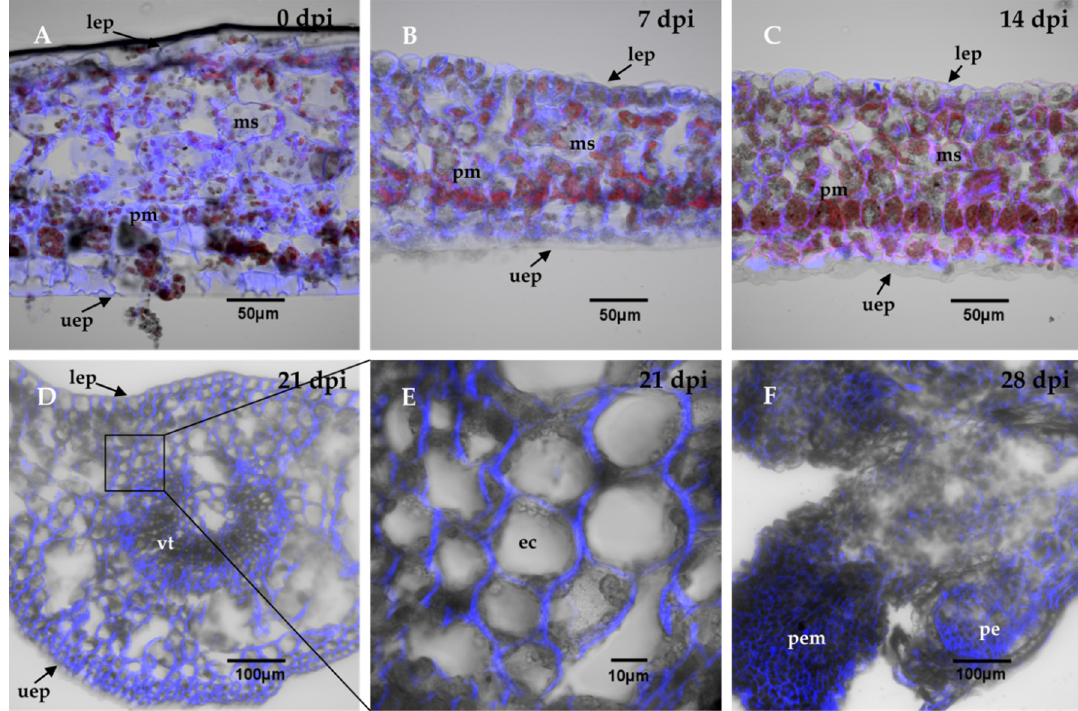
Figure 2. Histological analysis during the SE induction process in C. canephora . The leaf explants were composed of parenchymal cells of the spongy mesophyll, sm, and palisade mesophyll, pm. There were no changes in the explant cell structure, as shown in panel ( A ), which corresponds to the induction day (0 day); ( B ), 7 dai, and ( C ), 14 dai. ( D ), From 21 dai, the appearance of embryogenic cells, ec, was observed near the vascular tissue, vt. ( E ), a close-up view of the explants 21 dai showed dense embryogenic cells. ( F ), 28 dai, the proembryos, pe, were formed. The cell wall was stained with calcofluor white and chlorophyll is indicated in red. Other abbreviations: proembryogenic mass: pem; upper epidermis: uep; lower epidermis: lep. 0, 7, 14, 21, 28 dai of SE 30 µm cross-sections.